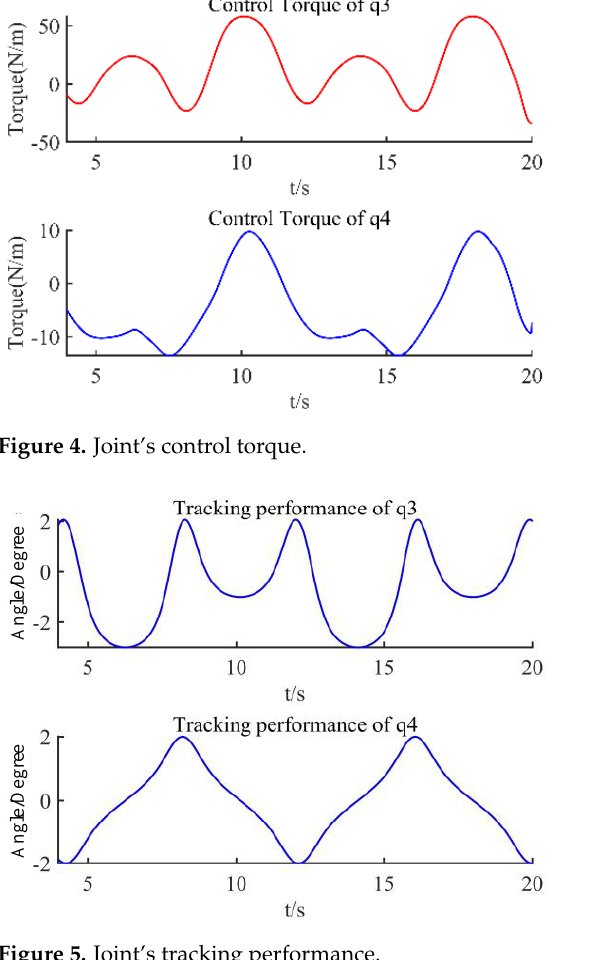
Figure 5. Joint’s tracking performance.